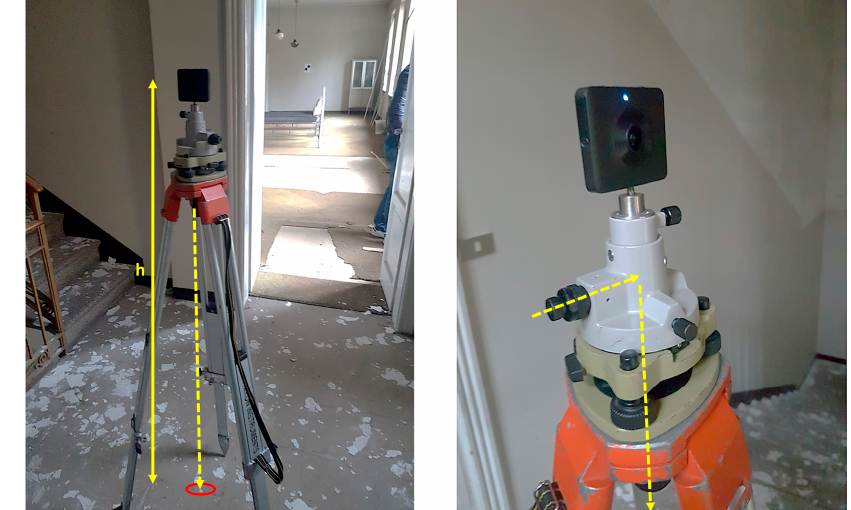
Figure 14. The repositioning tool used to set up the camera at different times. The device has an optical plummet to reposition the camera over a point marked on the ground. The measurement of the vertical distance is simply carried out with a metric tape. Finally, the device is leveled with three screws on the tribrach.